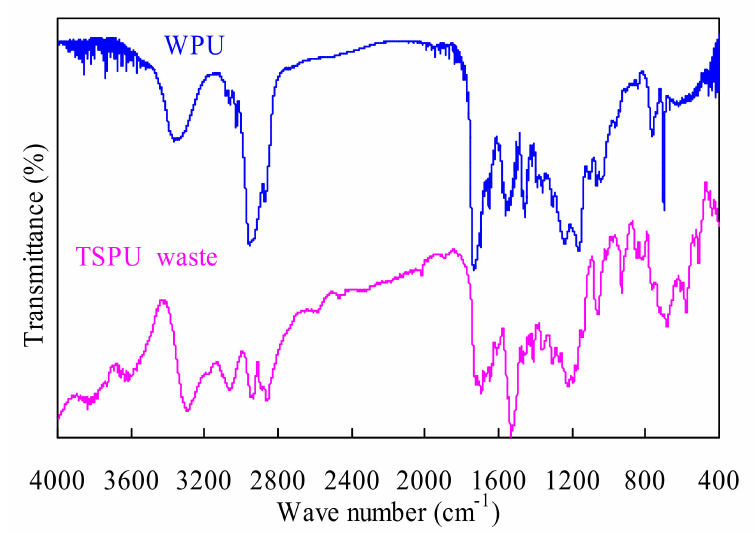
Figure 1. FTIR spectra measured for TSPU waste and WPU